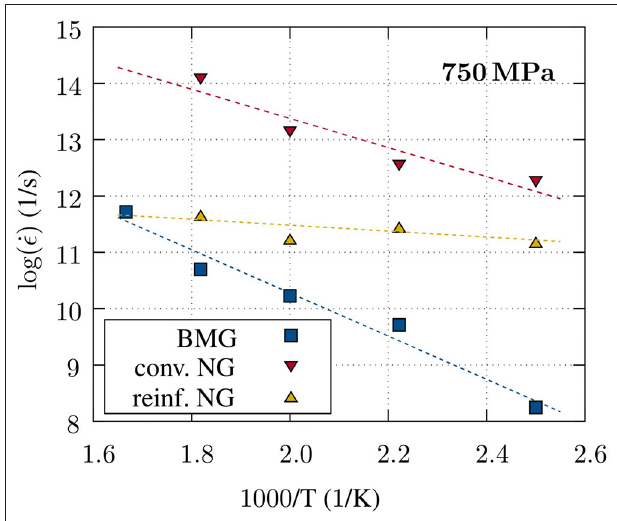
FIGURE 4 | Comparison of the temperature dependence of the fitted creep rates for the three different glass types.